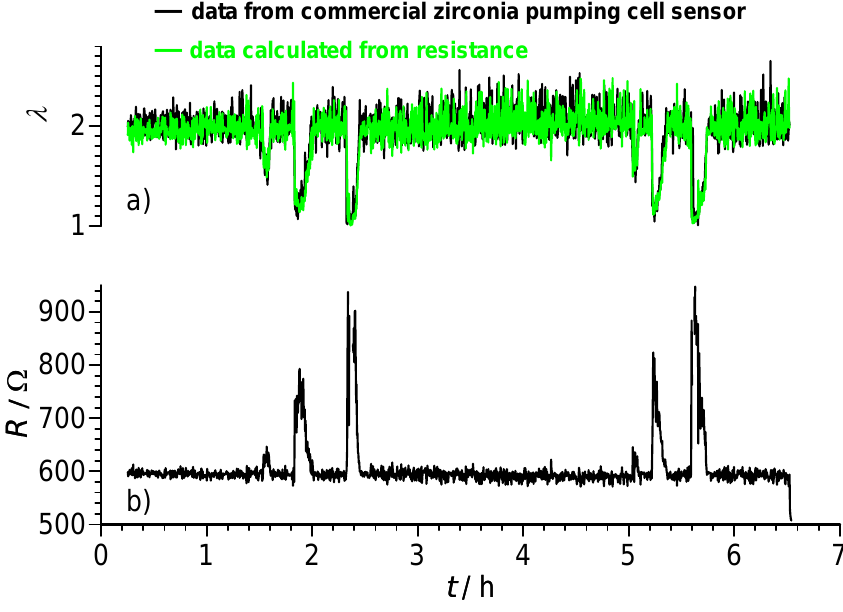
Figure 6. (a) Part of a real exhaust test that compared a resistive and a zirconia pumping cell oxygen sensor. (b) Measured resistance of the STF sensor. Note: the good agreement between both types of sensors. After [45], reprinted with permission from